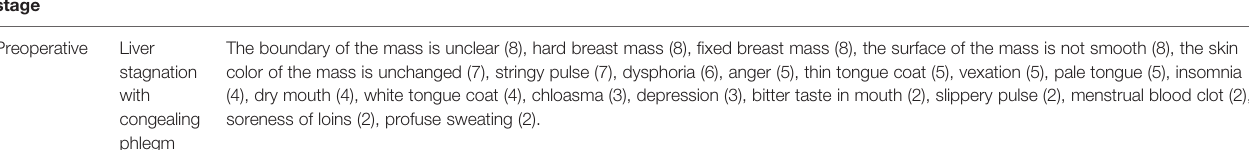
TABLE 4 | Hierarchical cluster analysis results by treatment stage. Treatment Syndrome Signs and symptoms stage